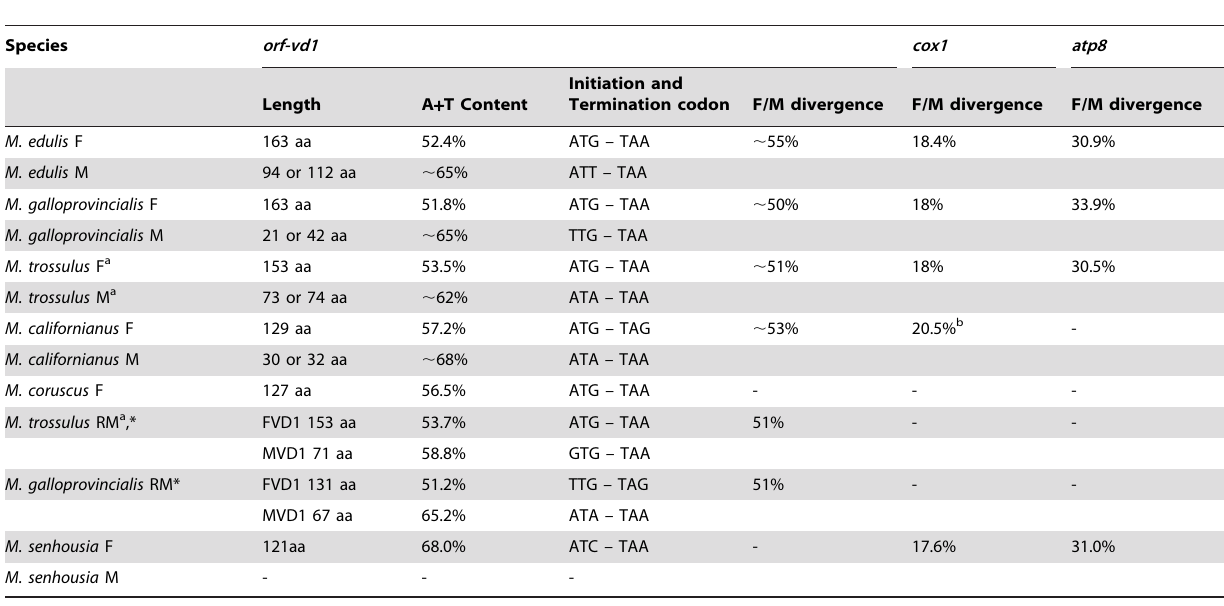
Table 2. General Characteristics of F and M ORFs in the VD1 domain of the Mytilus spp.